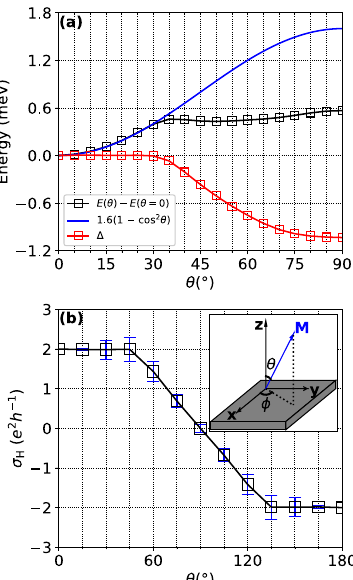
Fig. 5 Total energy and AHC as a function of spin-orientation angle. a Total energy at spin-orientation angle θ (black line and marker), where total energy of θ = 0 ∘ is set to be zero. By interpolating the calculated total energy of 0 ∘ ≤ θ ≤ 30 ∘ , we obtain fi tting function indicated as blue line. Difference between total energy and the fi tting function are depicted as red line and marker. b Azimuthal spin angle ( ϕ ) averaged AHC as a function of polar angle ( θ ). Upper right panel shows de fi nition of polar angle ( θ ) and azimuthal spin angle ( ϕ ) of magnetization vector M together with CrSiTe 3 monolayer described as gray slab. Black line with square marker and blue errorbar in AHC graph correspond to average and standard deviation of AHC as a function of ϕ for each θ .